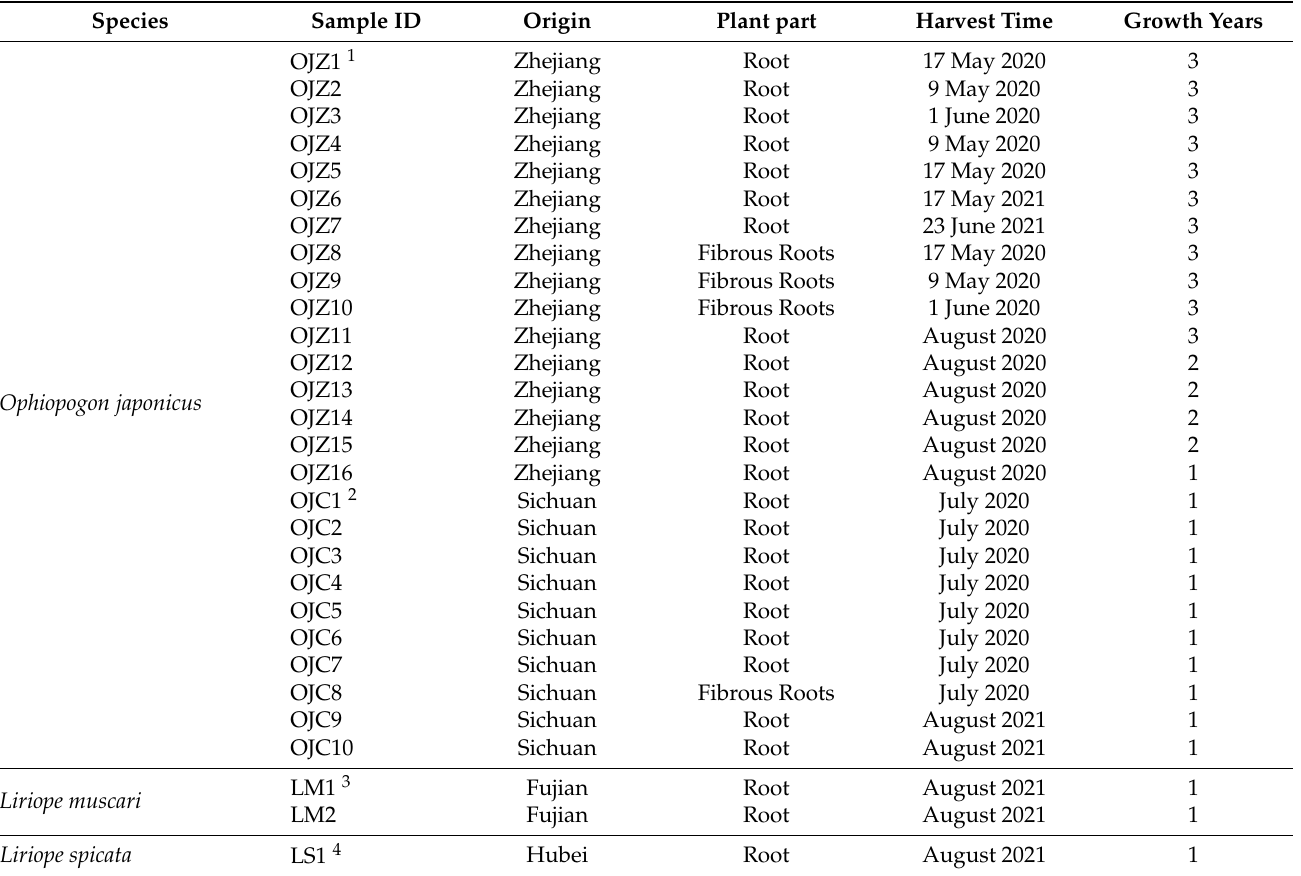
Table 1. The detailed information of 29 samples of Maidong